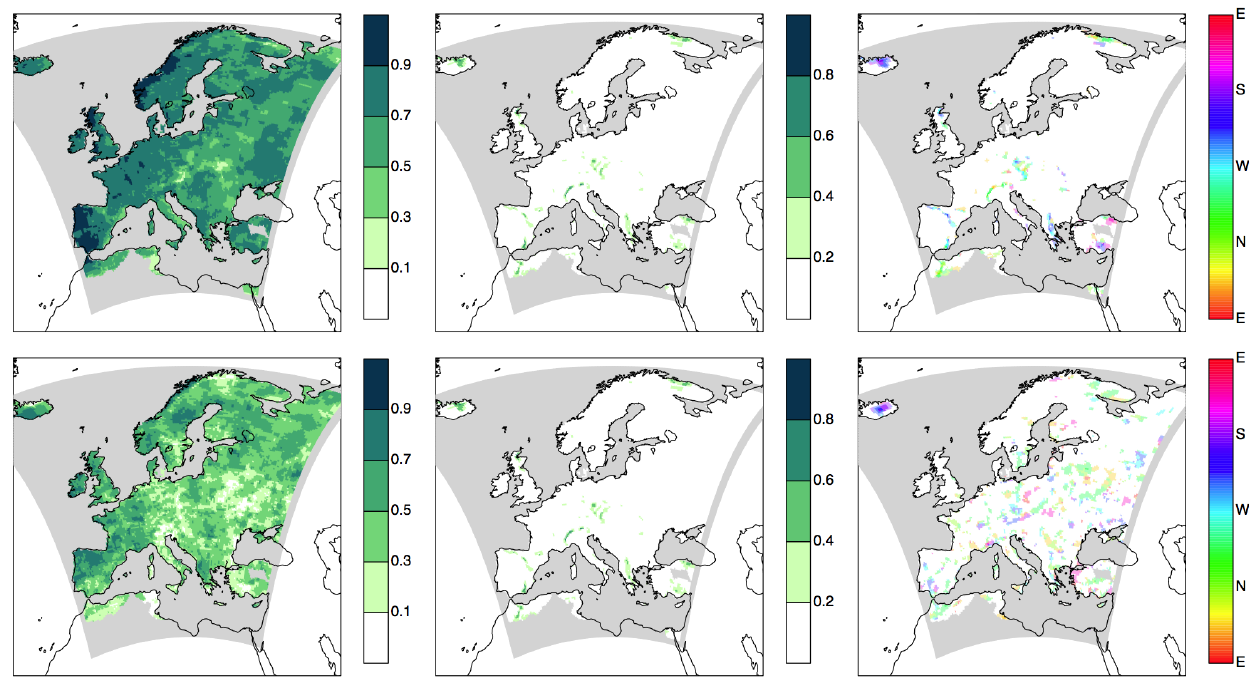
Figure 3. Non-local representativeness. Top panels: DJF; bottom panels: JJA. Left panels: correlation between observed seasonal mean time series and modelled time series at a non-local grid box that maximises correlation with observations; centre panels: improvement in correlation by using non-local series; right panels: direction of a model grid box that maximises correlation relative to the local grid box. Areas where correlation does not improve by at least 0.2 are shown in white.